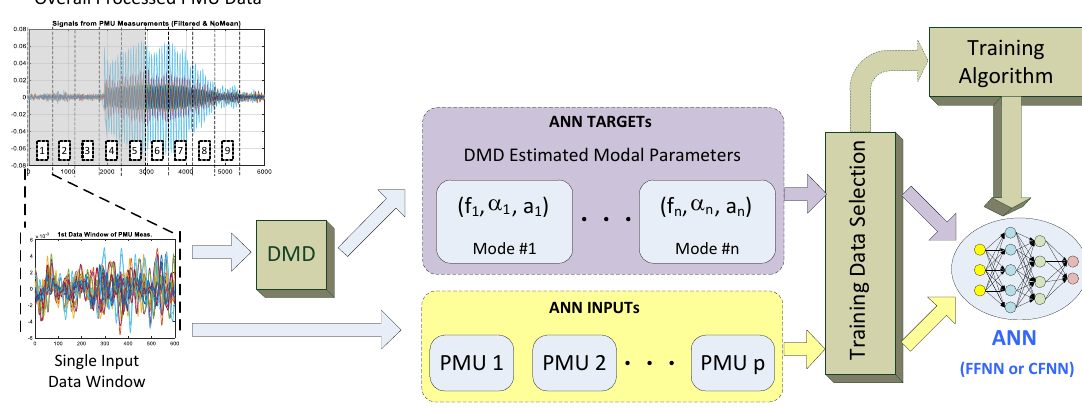
Figure 3. Overall scheme for the training stage of the ANNs.